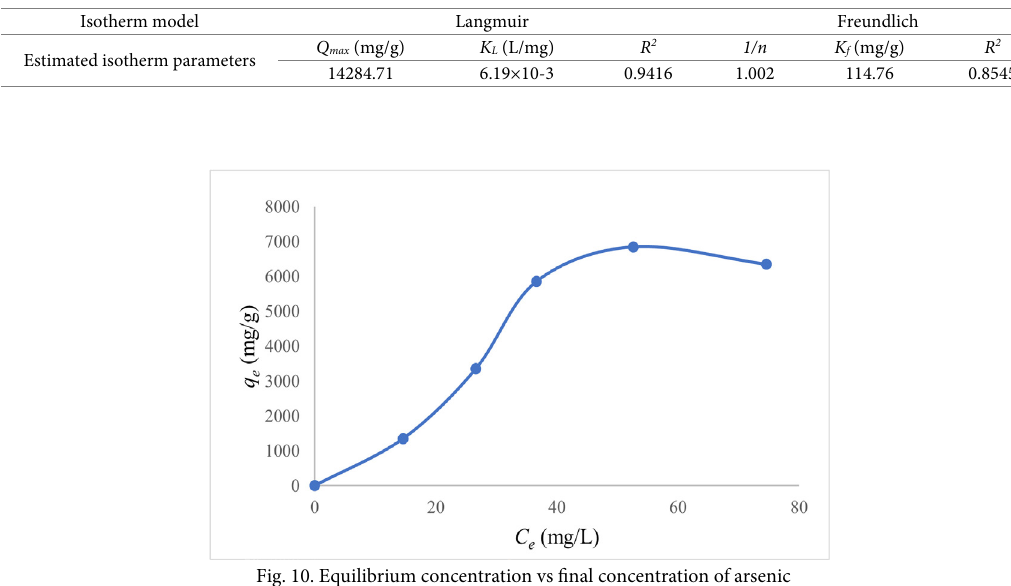
Table 6. Isotherm parameters for Langmuir and Freundlich models